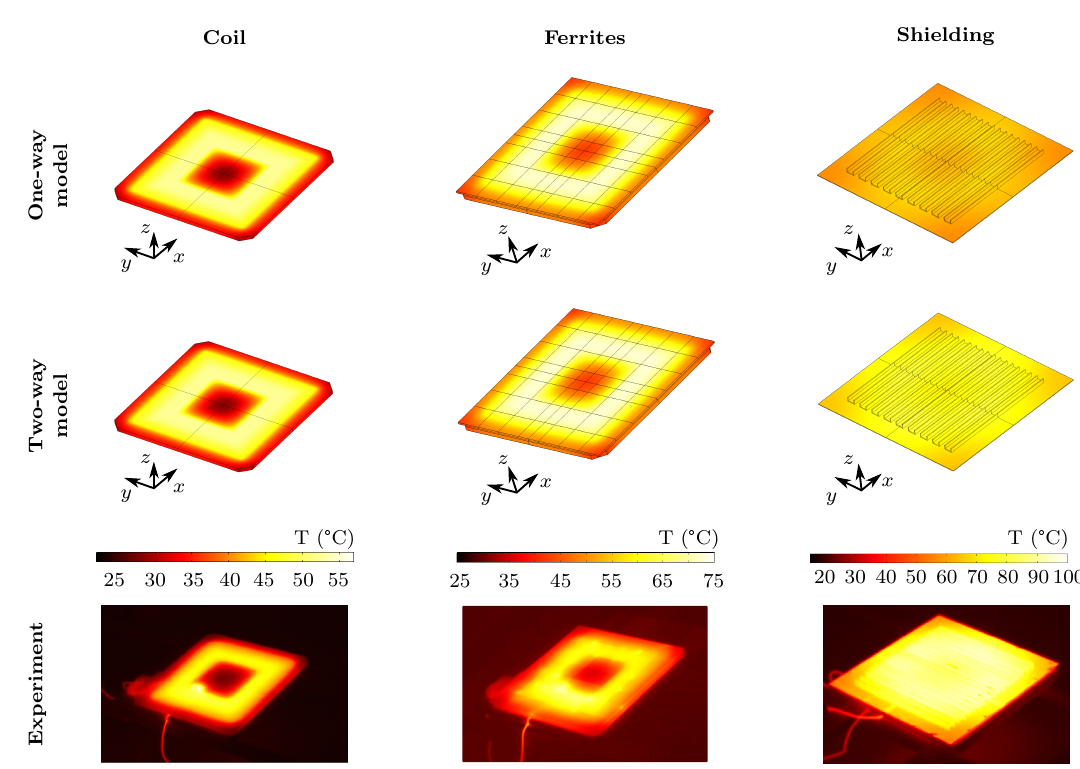
Figure 6. Component-level simulation and experimental validation of the electromagnetic–thermal simulation models’ steady-state behavior. The thermographic images were each taken for comparison after the maximum operation